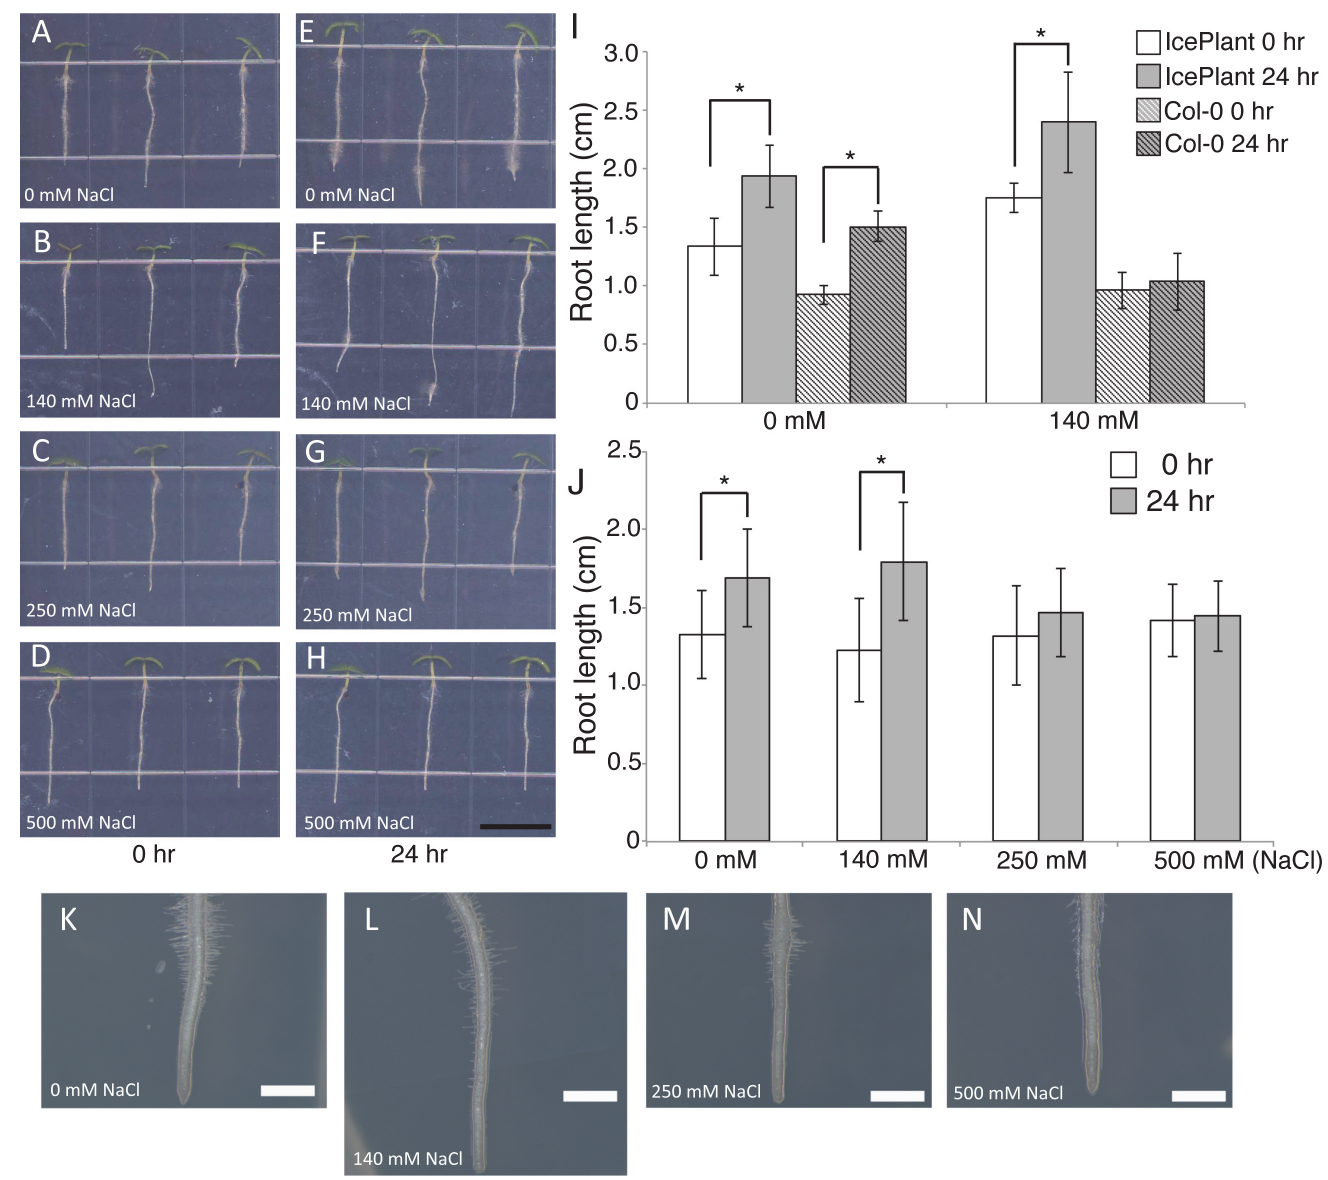
Fig 1. Effect of NaCl on root growth in ice plants. (A-D) Five-day-old ice plant seedlings grown on the MS medium prior to NaCl treatment. (E-H) five-day- old ice plant seedlings after 24 h on MS containing 0 mM NaCl (E), 140 mM NaCl (F), 250 mM NaCl (G), or 500 mM NaCl (H). Bar = 1 cm. (I) Root length in five-day-old ice plant and Arabidopsis thaliana Col-0 ecotype seedlings (white boxes and white boxes with diagonal lines) and that of the same roots after 24 h on plates containing 140 mM NaCl (gray boxes and gray boxes with diagonal lines). Mean ± standard deviation (SD) (n = 15): * p < 0.001, as determined by a Student ’ s t -test. (J) Root length in five-day-old ice plants (white boxes) and that of the same roots after 24 h on the indicated concentration of NaCl (gray boxes). Mean ± standard deviation (SD) (n = 15): * p < 0.001, as determined by a Student ’ s t -test. (K-N) Morphological changes in root hairs on roots of ice plant seedlings treated with 0 mM (K), 140 mM (L), 250 mM (M) or 500 mM NaCl (N) for 24 h. Bar = 1